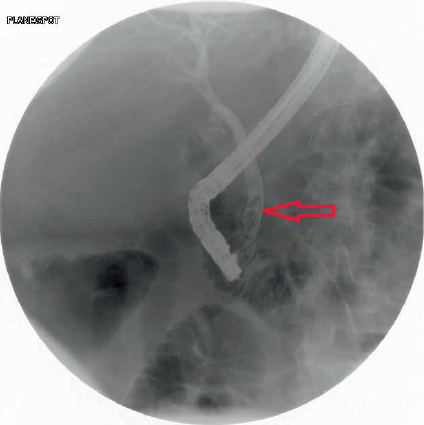
Figure 1: ERCP shows multiple stones in the common bile duct (red arrow).